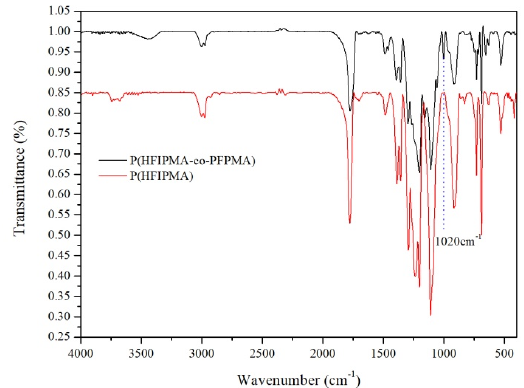
Figure 1. The infrared spectra of synthesized P(HFIPMA-co-PFPMA) and P(HFIPMA).